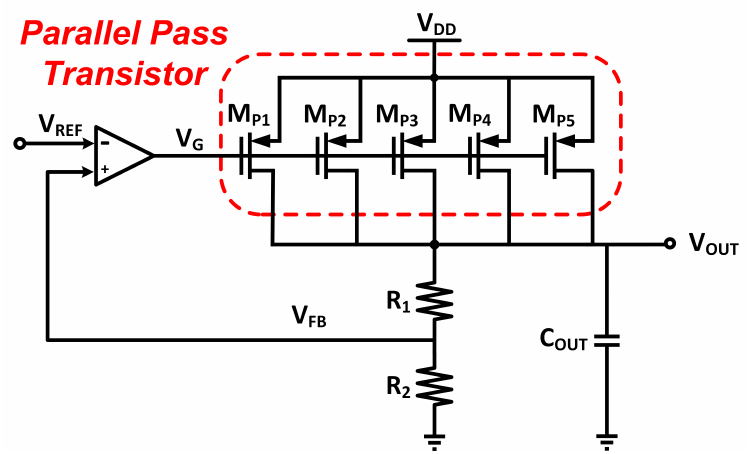
Figure 7. Parallel pass transistor